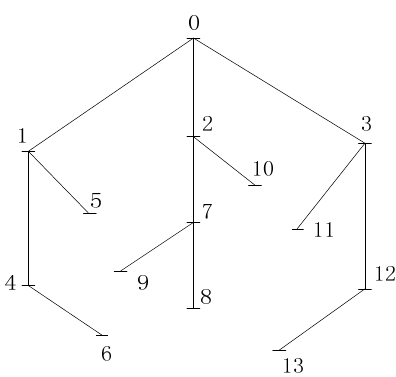
Figure 7. Schematic of the IEEE 14-node system.